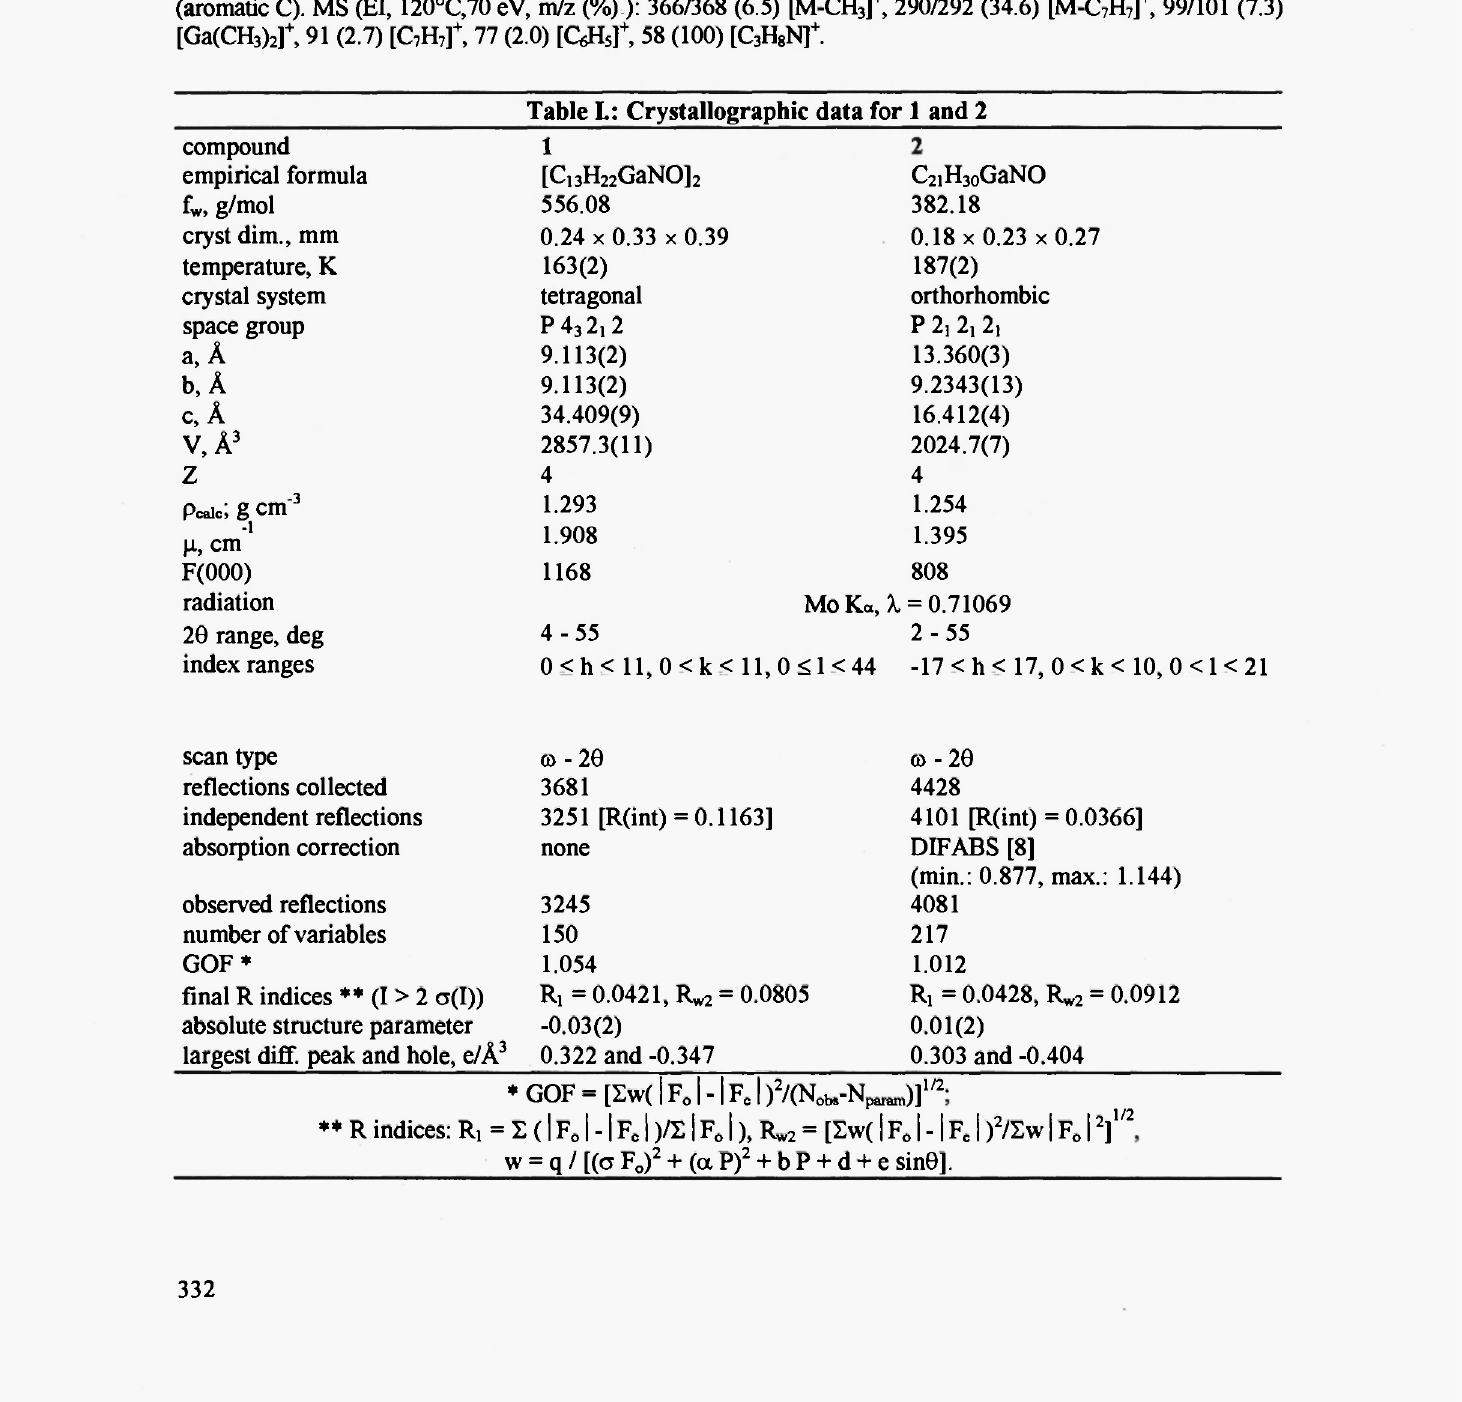
Table L: Crystallographic data for 1 and